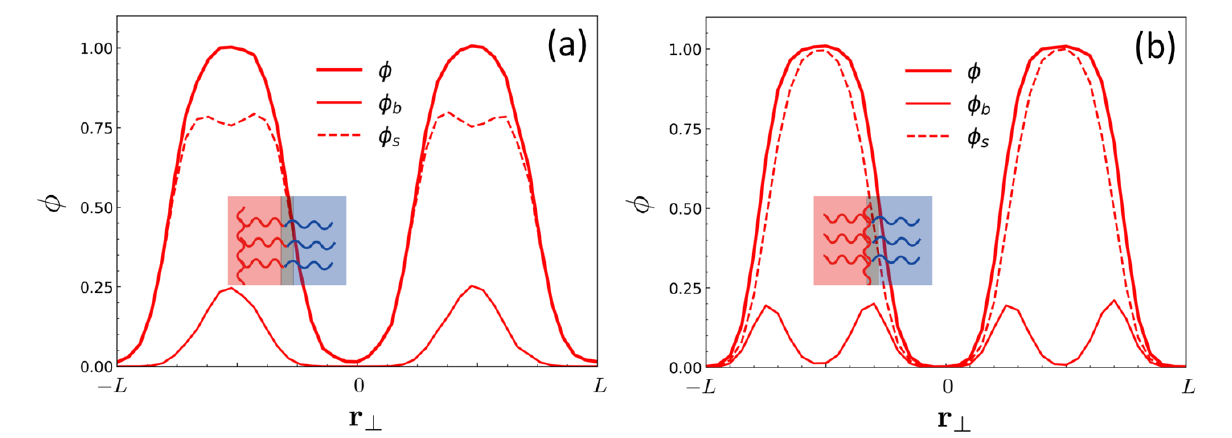
Figure 4. The local volume fraction of A-monomers ( φ ), that belonging to the backbone ( φ b ), and that belonging to the side chain ( φ s ) in the direction perpendicular to the lamellar interface ( r ⊥ ) obtained by DPD simulations for ( a ) { M = 12, N = 14, λ = 0 } and for ( b ) { M = 12, N = 14, λ = 6/13 } . All profiles were obtained at ∆ a / k B T = 3.5. The pictures in the inset show the schematic representa- tions of BBC organization in the lamellar phase with a half pitch for each